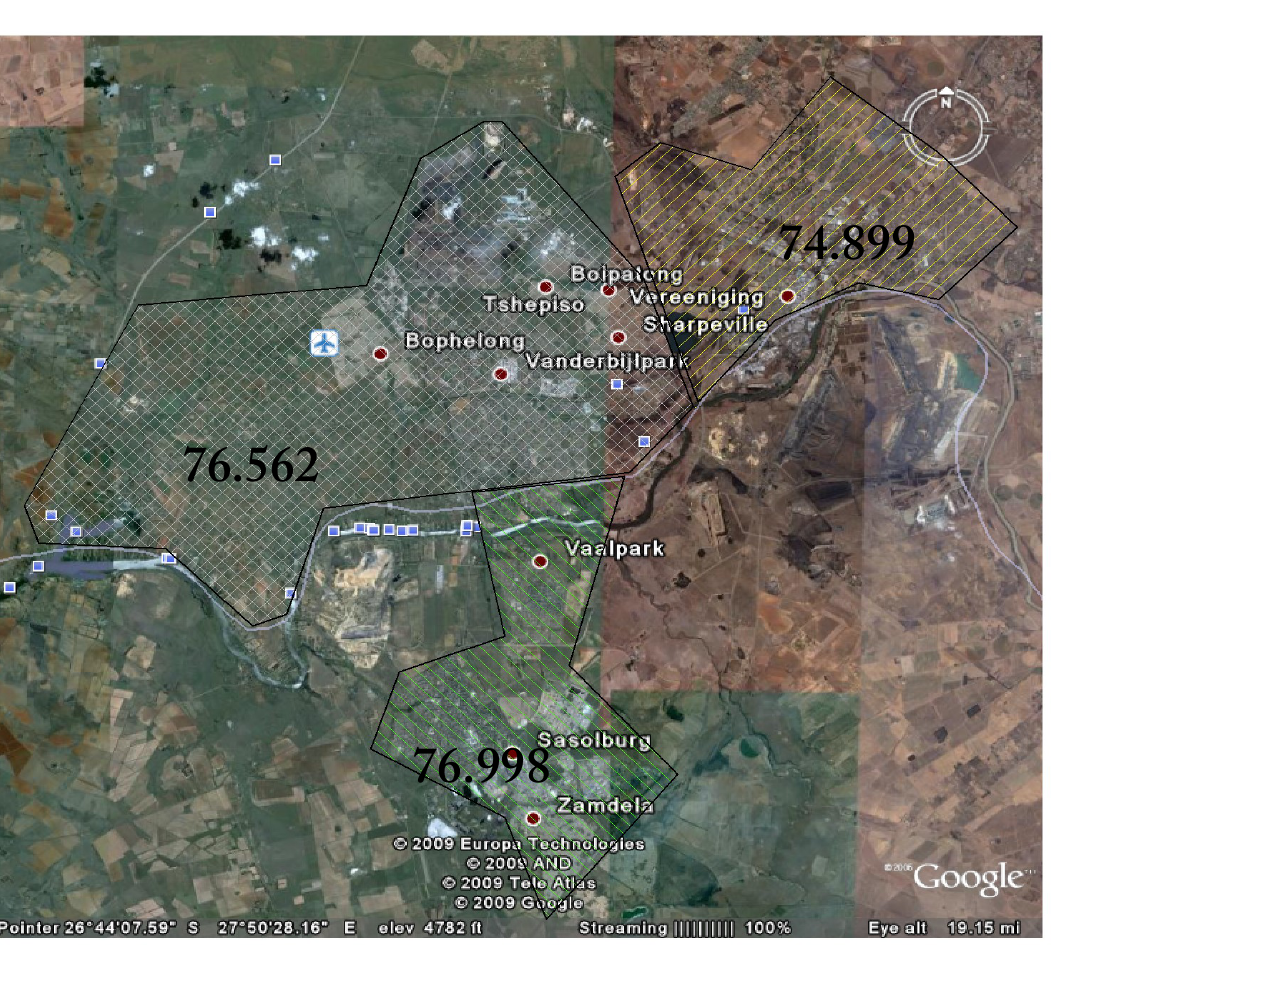
Figure 7 Water poverty map for the Vaal